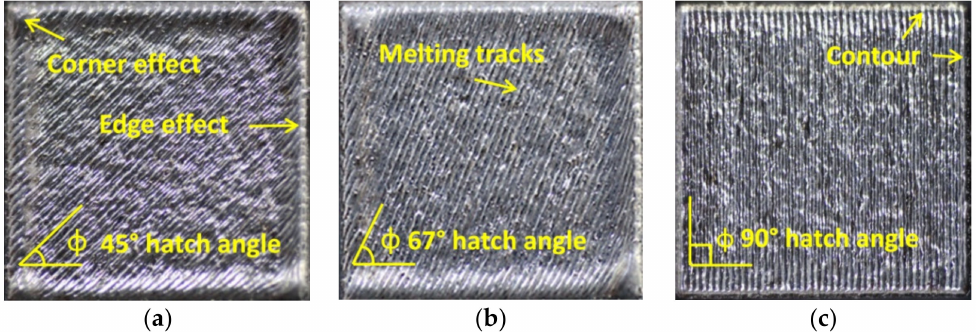
Figure 2. Macroscopic views of the top surface of cubic samples built with contour scan and different hatch angle rotations: ( a ) 45 ◦ , ( b ) 67 ◦ , and ( c ) 90 ◦